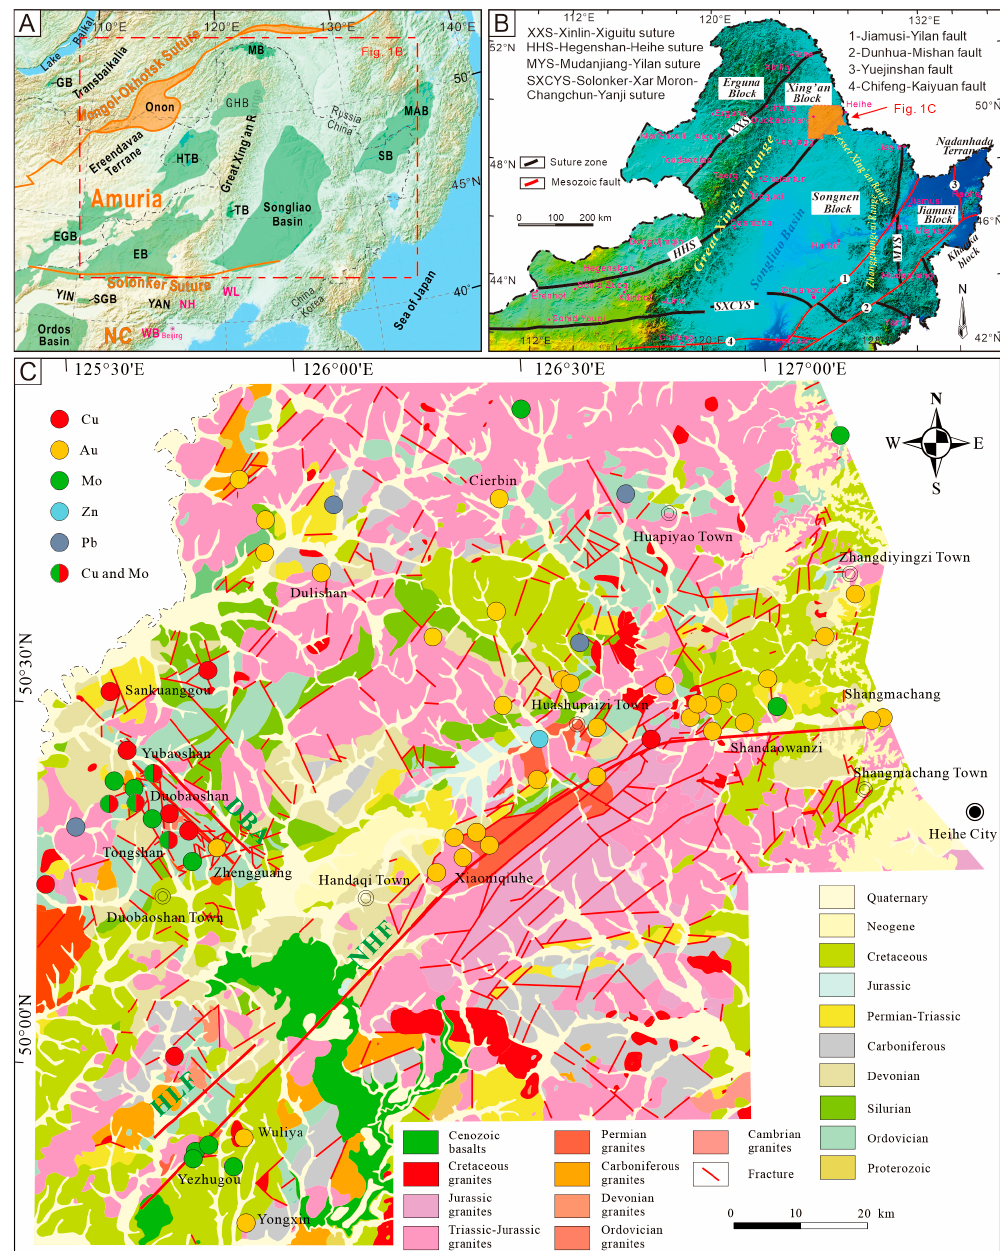
Figure 1. ( A ) Schematic diagram of the structure of the Central Asian orogenic belt, ( B ) tectonic zoning of northeastern China, and ( C ) brief geologic and mineral map of the Nenjiang–Heihe metallogenic belt. DBA—Duobaoshan Anticlinoria; NHF—Nenjiang–Heihe Fault; HLF—Huolongmengou Fault.